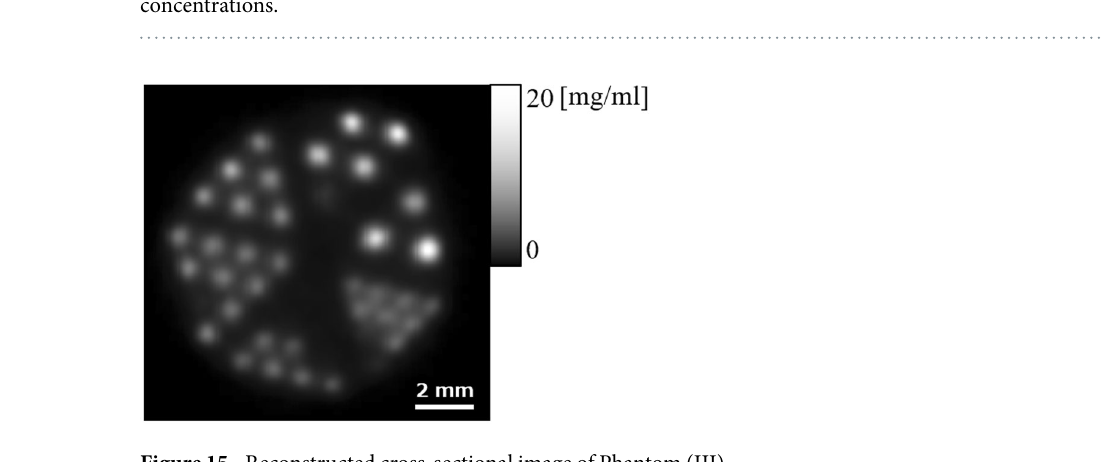
Figure 14. Relationship between the I concentrations estimated using mp-FXCT and the actual I concentrations.